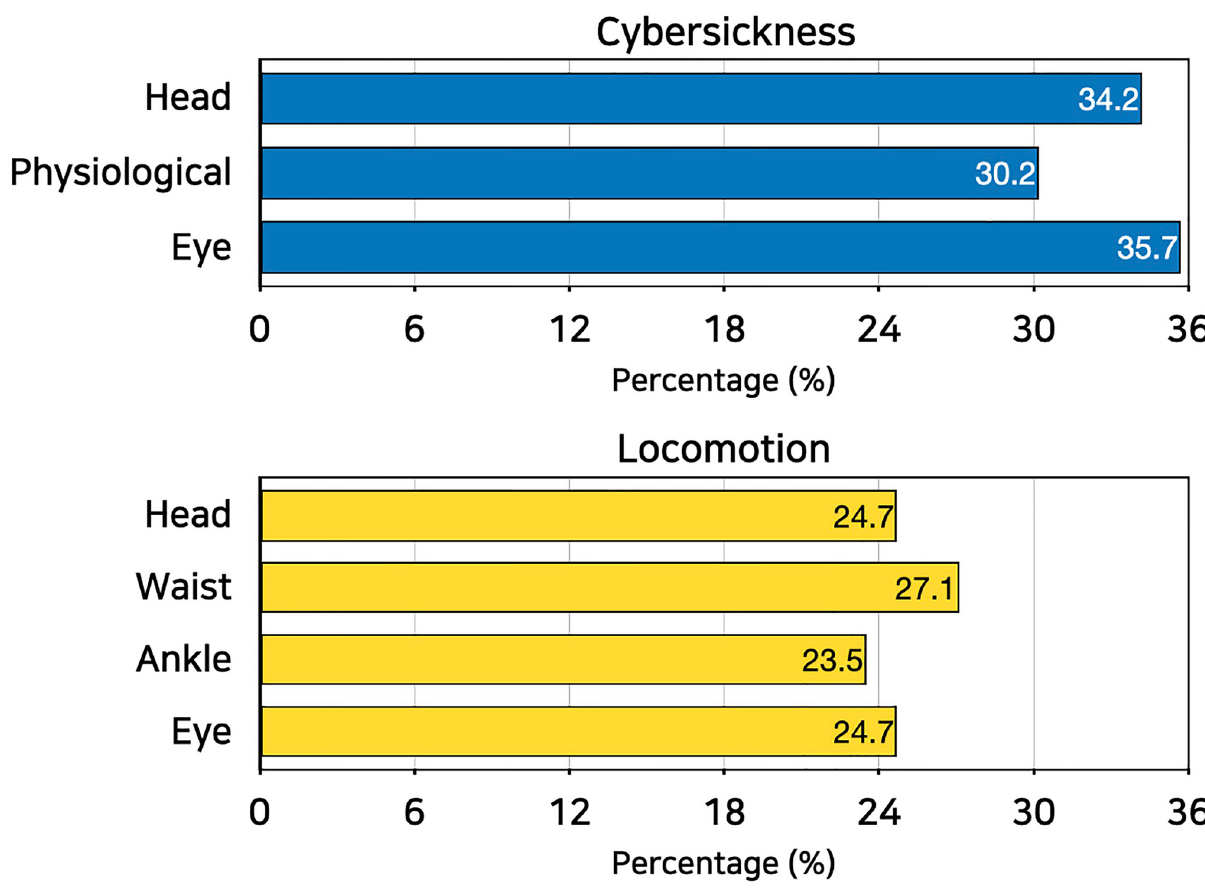
Fig 4. Attention weights of data modalities.